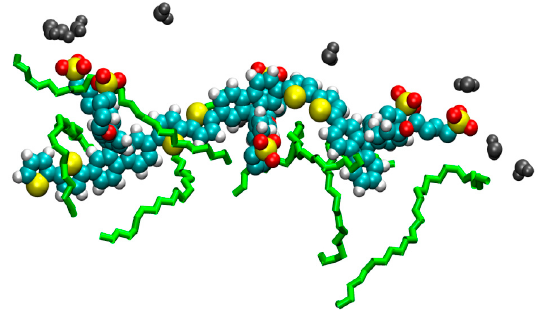
Figure 7. The polymeric part of PBS-PF2T surrounded by C 12 E 5 (green) and sulfonate groups interacting with water (grey van der Waals).